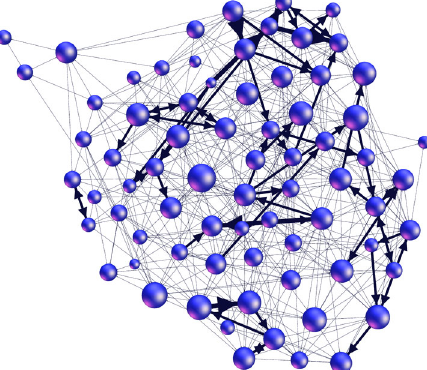
FIG. 2. Combined student network in the MI course for Fall 2014 drawn using the Force Atlas algorithm on Gephi [66]. Sphere size represents PageRank centrality and edge thickness represents weight of tie. Instructors have